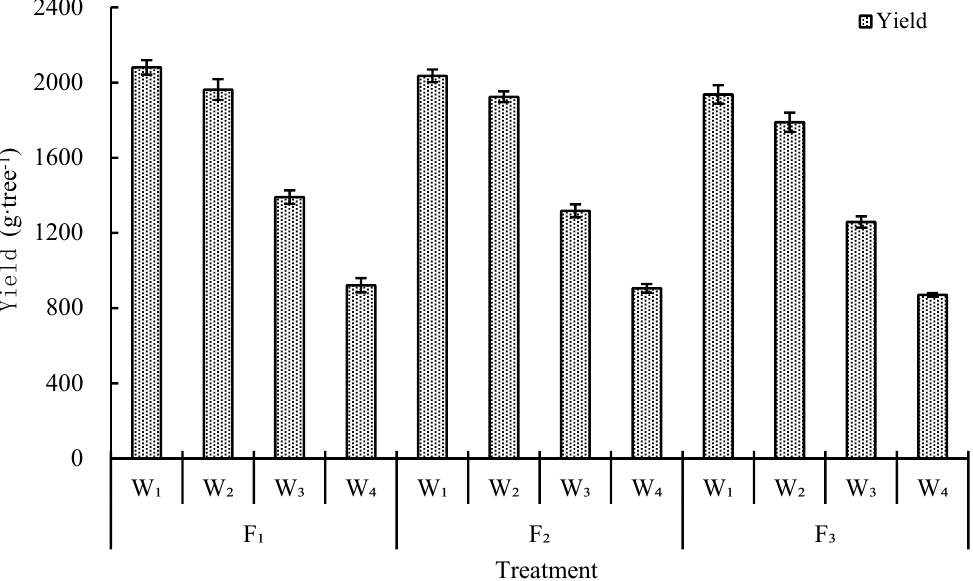
Figure 6. Effects of different water and fertilizer treatments on yields of young apple trees in 2013. Irrigation and fertilizer had a very significant impact on apple yield ( p < 0.01), and the interaction of water and fertilizer was significant ( p < 0.05).